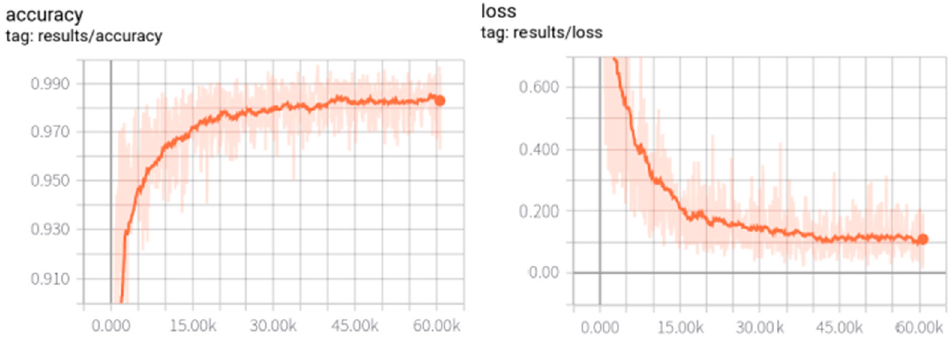
Figure 6. The accuracy curve and loss curve output during the training process. From the training process in the Figure 6, it can be seen that the accuracy rate steadily increases as the iterative process proceeds, while the loss curve decreases until